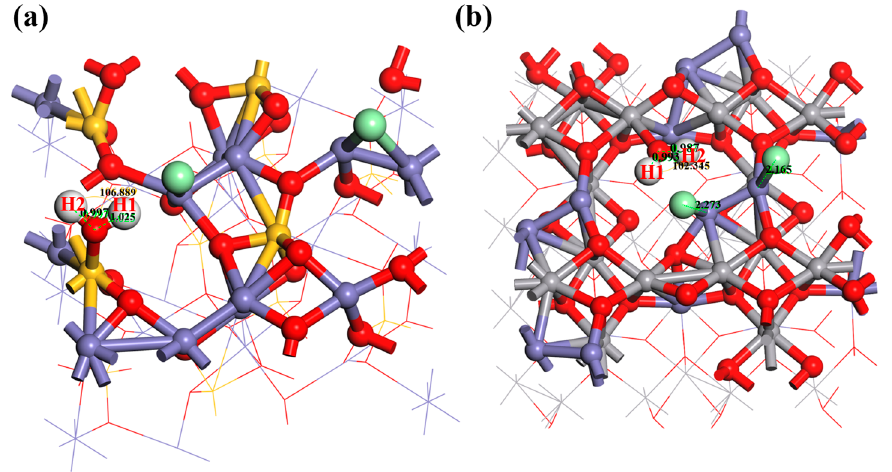
Figure 10. Optimized ( a ) Fe 2 SiO 4 (010) and ( b ) FeV 2 O 4 (001) Fe-terminated surface with H 2 O − . Table 5. Structure parameter of formed H 2 O − . Angle of H-O-H (Degree)